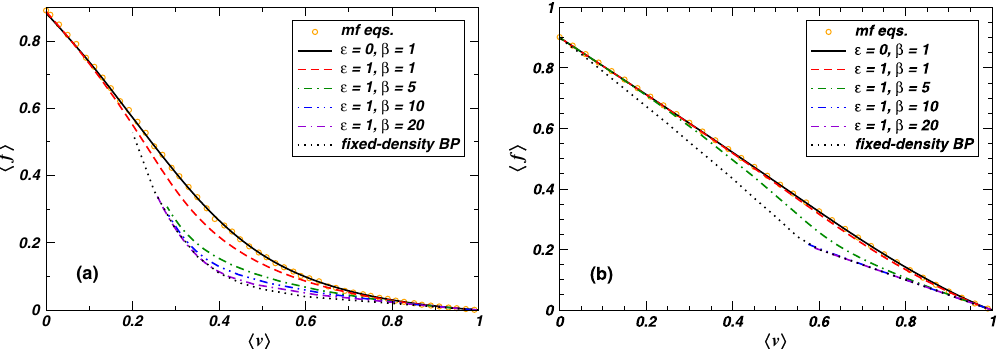
FIG. 5. Results for the analysis of the SIR and SIS models on random regular graphs of degree K ¼ 4 , with uniform self-infection probability q ¼ 0 . 1 and uniform transmission probability p ¼ 0 . 5 . (a) For the SIR model, we plot the average density of nodes that got infected during the epidemic spreading h f i as a function of the average density h v i of immunized nodes. BP results on infinitely large graphs are reported for ϵ ¼ 0 and β ¼ 1 (black solid line) and for ϵ ¼ 1 and β ¼ 1 (red dashed line), 5 (green dot-dashed line), 10 (blue double-dot-dashed line), and 20 (violet dot-double-dashed line). Results of sampling over Eqs. (5a) and (5b) (orange circles), corresponding to random immunization, are also displayed. (b) For the SIS model, we plot the average density h f i of infected nodes in the stationary state as a function of the average density h v i of immunized nodes. BP results on infinitely large graphs are reported for ϵ ¼ 0 and β ¼ 1 (black solid line) and for ϵ ¼ 1 and β ¼ 1 (red dashed line), 5 (green dot-dashed line), 10 (blue double-dot-dashed line), and 20 (violet dot-double-dashed line). Results of sampling over Eq. (7) (orange circles), corresponding to random immunization, are also